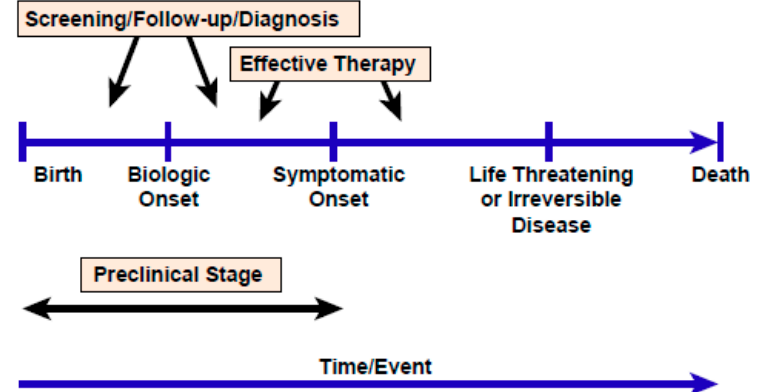
Figure 3. The rationale for early diagnosis via newborn screening by applying the principle inherent in the preventive medicine strategy to detect disease before its symptomatic onset.